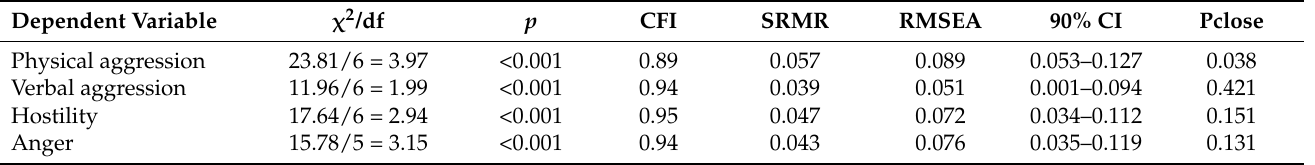
Table 4. Fit indices of the path